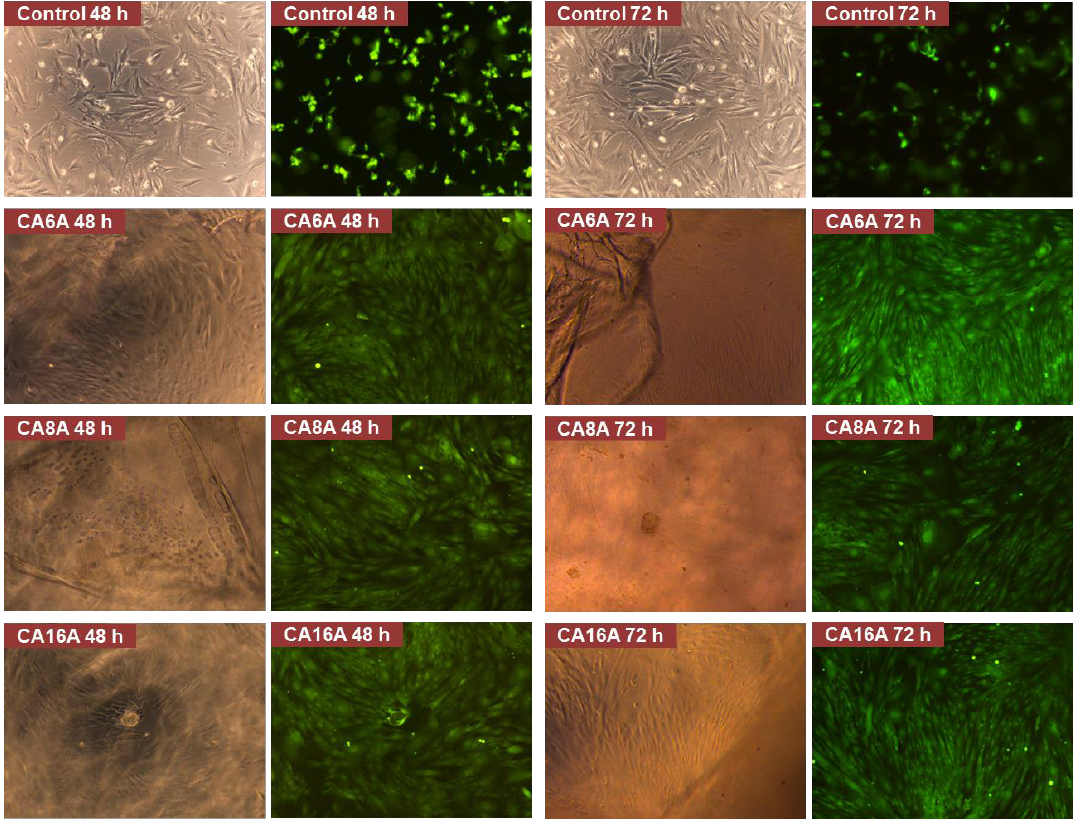
Figure 9. Live / dead staining assay images of negative control and cells after incubation with di ff erent hydrogels (magnification 10 ×